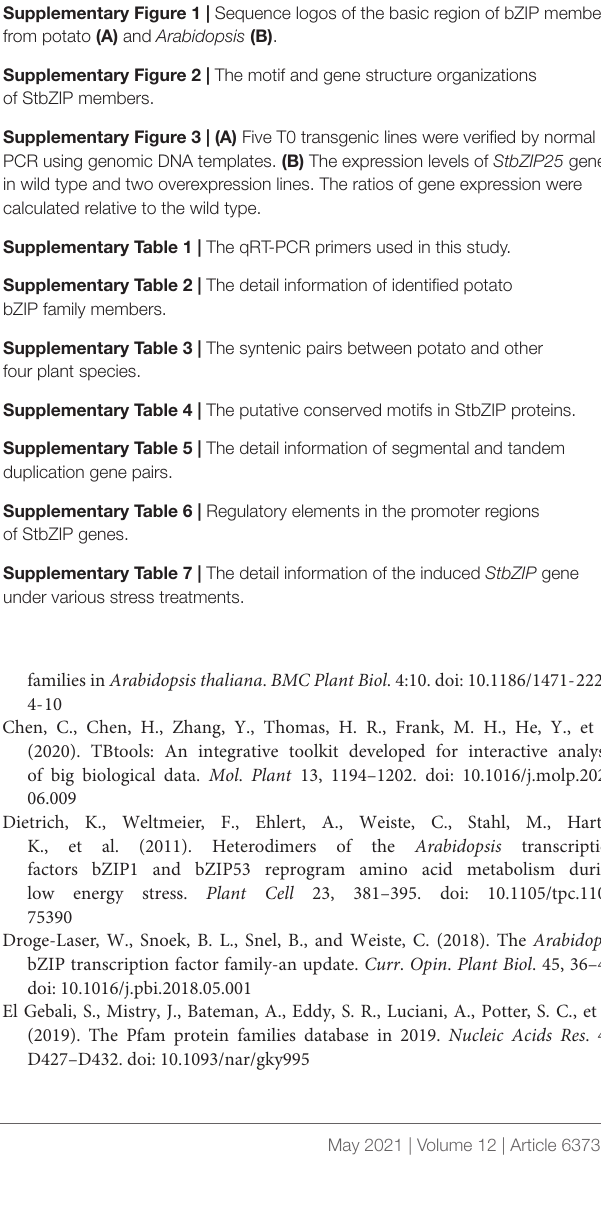
Supplementary Figure 1 | Sequence logos of the basic region of bZIP members from potato (A) and Arabidopsis (B) . Supplementary Figure 2 | The motif and gene structure organizations of StbZIP members.